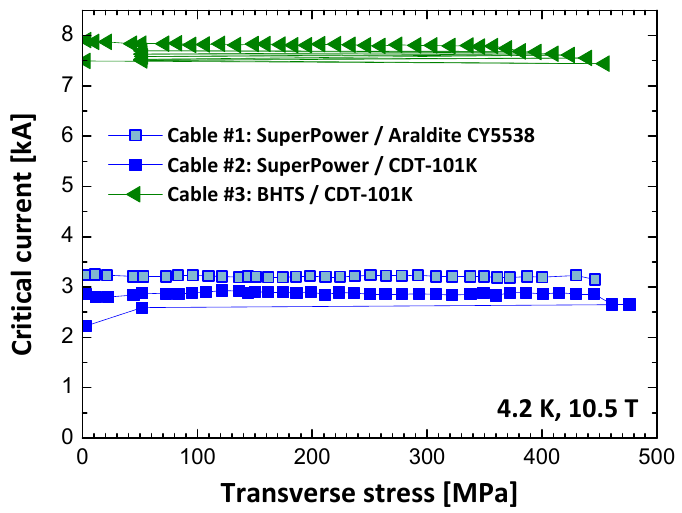
Figure 15. Critical current versus applied transverse pressure for three 15-tape REBCO Roebel cables: Cable #1 and Cable #2 are assembled from SuperPower tape and impregnated with Araldite CY5538 and CDT-101K, respectively. Cable #3 is made with BHTS tape and impregnated with CDT-101K. Adapted from Ref. [61].